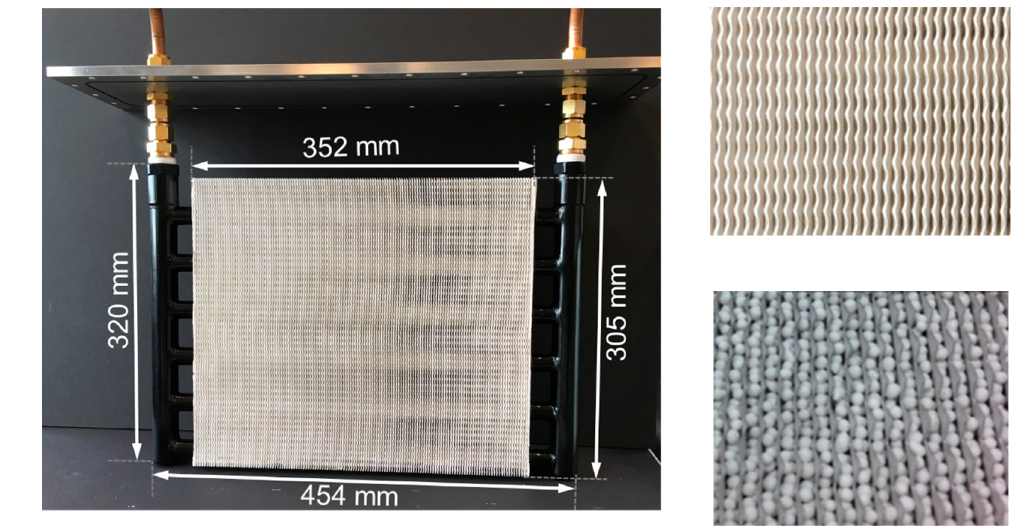
Figure 6. Round tube–corrugated fin adsorber bed with FAM-Z02-coated and -packed configurations [12,15].